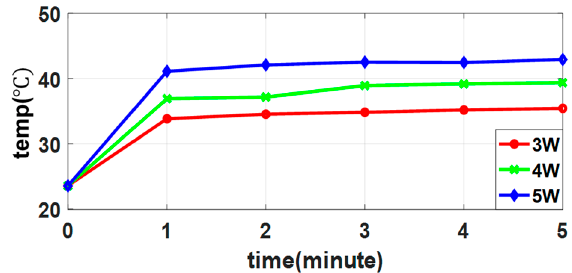
Figure 7. Measured temperature curves of wearable textile heater for different PA power values.